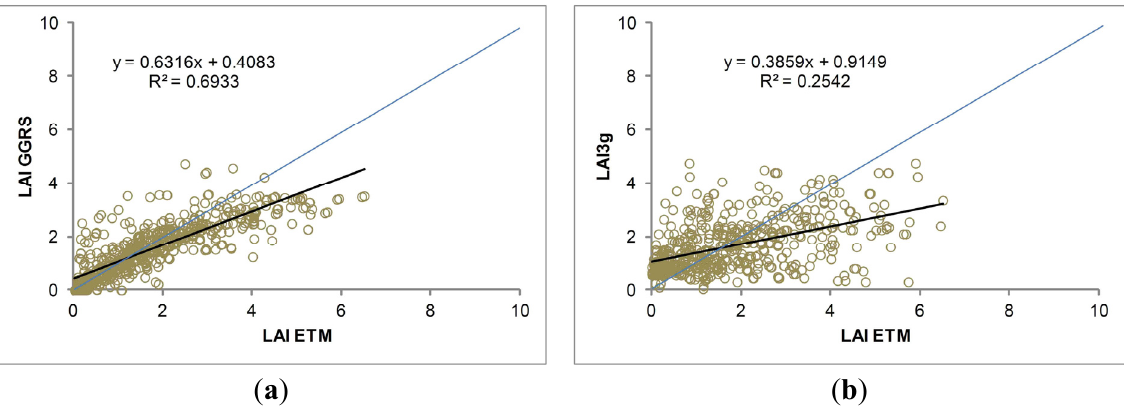
Figure 3. Validation of LAI products over forests in the Almaty test region for August 2010. Pixel-by-pixel ( n = 846) comparison of the aggregated fine-resolution Landsat-derived LAI map versus the LAI GGRS product ( a ); and versus the LAI3g product ( b